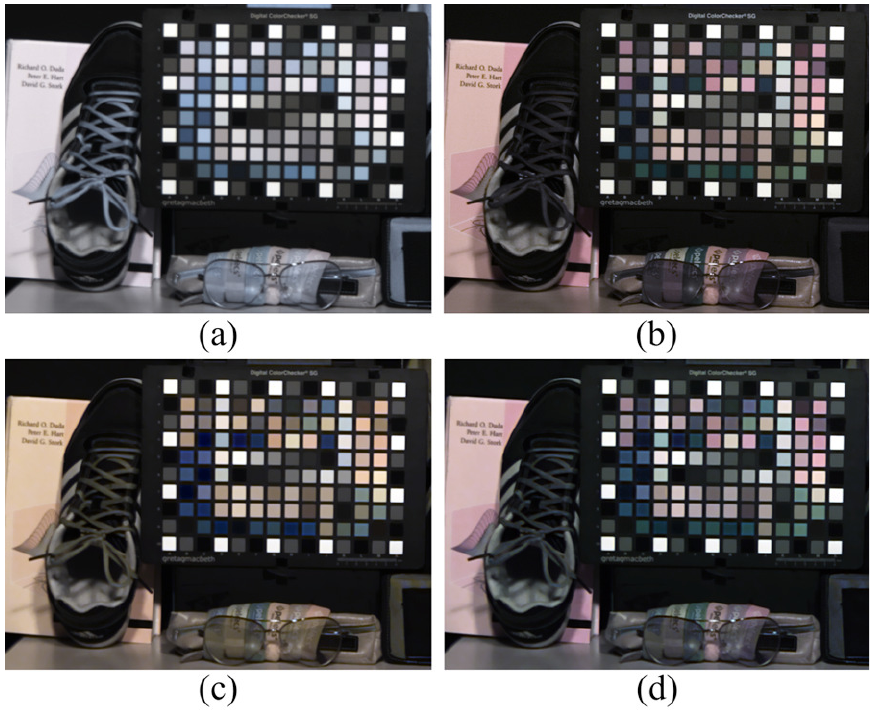
Figure 20. Two-step color restoration result comparison (1 lx). ( a ) Input image; ( b ) optical filtered visible band image; ( c ) proposed method without two-step color restoration; ( d ) proposed method with two-step color